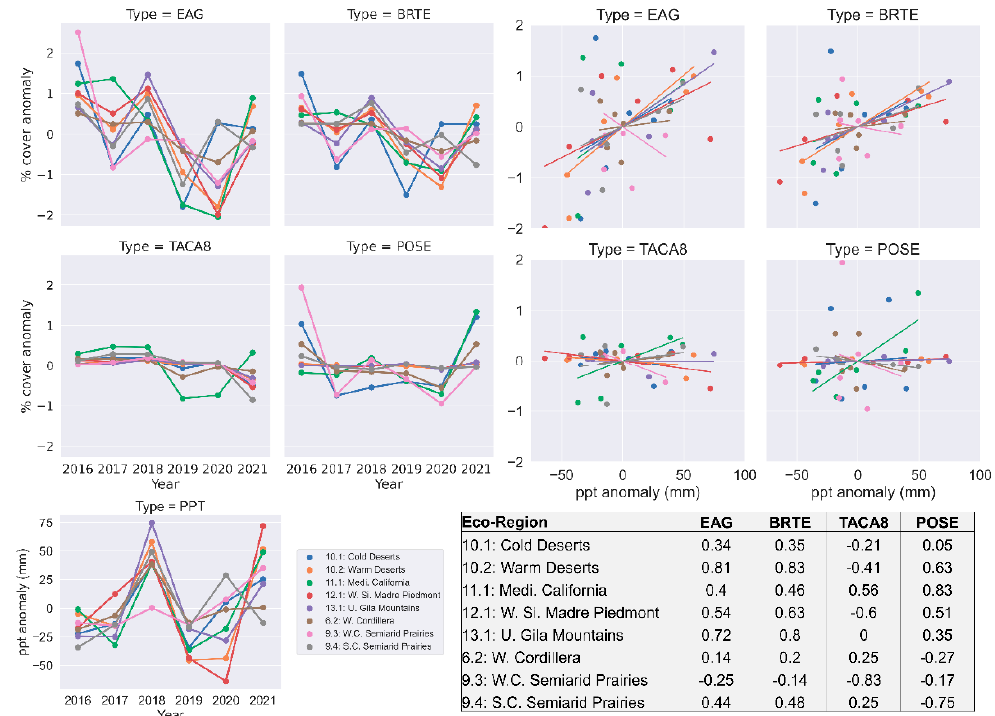
Figure 8. Time series of the annual average species cover abundance and hydrologic year precipitation (October–June) anomalies ( left ), scatterplot ( top - right ), and correlation matrices ( bottom - right ) of species abundance anomalies with hydrologic year precipitation anomalies for Omernik Level II ecoregions [25]. EAG represents a combination of 16 exotic annual grasses, BRTE is cheatgrass, TACA8 is medusahead, POSE is Sandberg bluegrass, and PPT is the sum of the previous October to current June precipitation. Year 2021 for the species percent cover is calculated using the July 2021 version of rapid mapping.